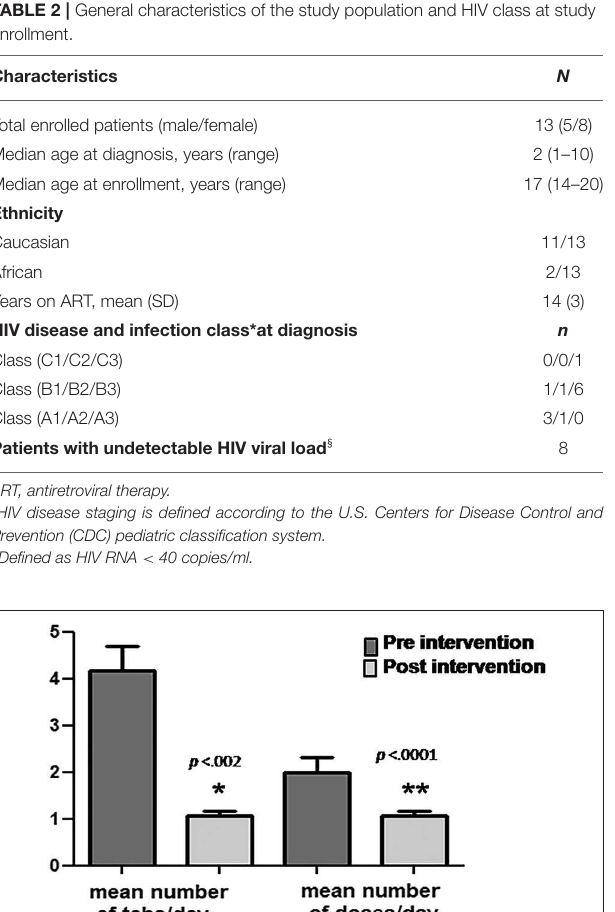
TABLE 1 | Bundle of interventions and their time points. TABLE 2 | General characteristics of the study population and HIV class at study